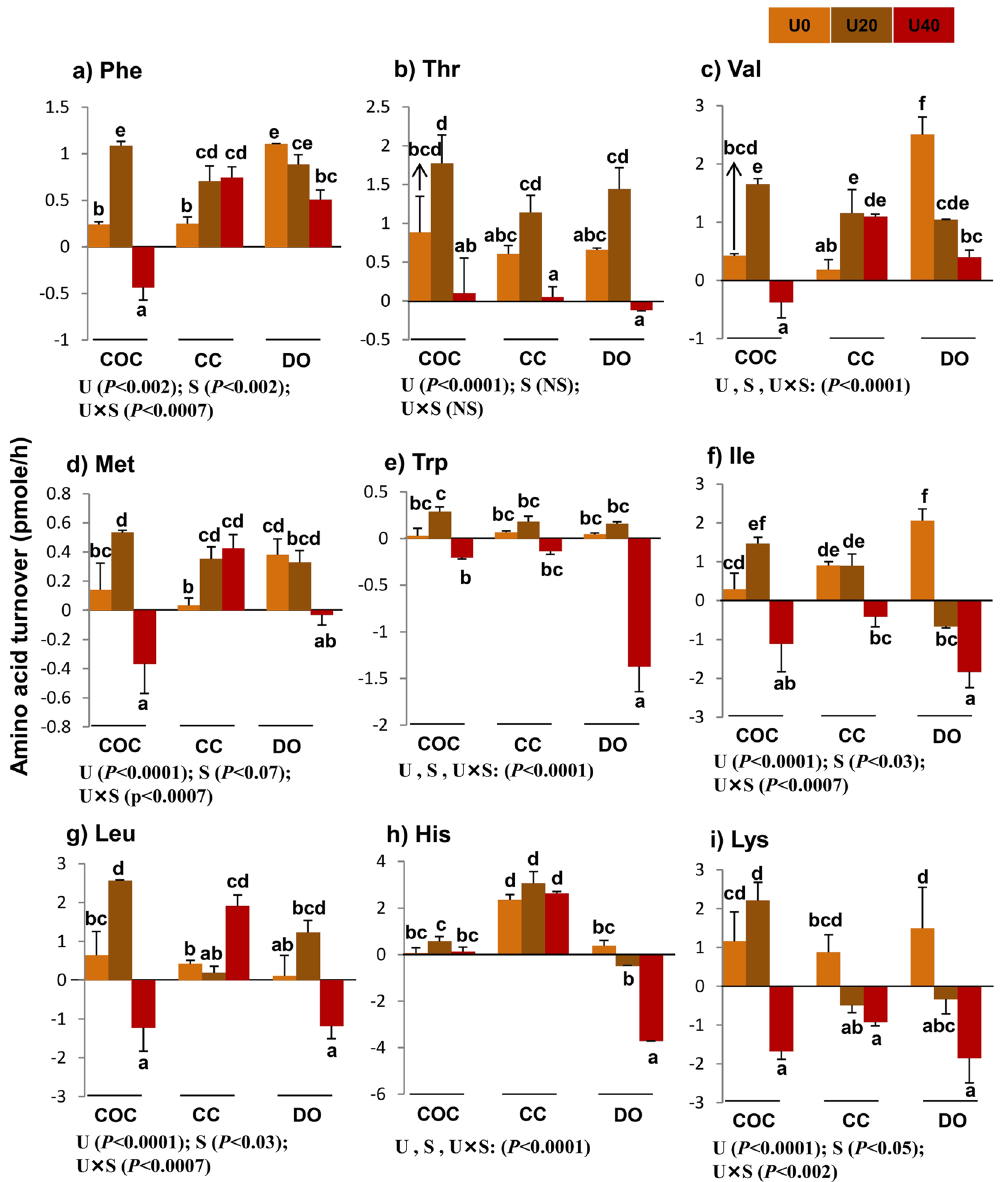
Figure 1. Effect of urea supplementation (0, 20, or 40 mg/dl) in maturation medium on the net depletion/ appearance of essential amino acids by bovine cumulus-oocyte complex, oocytectomized cumulus cells, or denuded oocytes after 24-h incubation. U0: control group (without urea); U20: 20 mg/dl urea; U40: 40 mg/dl urea. COC: cumulus oocyte complex; CC: cumulus cells; DO: denuded oocytes; U: the main effect of urea; S: the main effect of specimens (cell type: COCs, DOs, and CCs); U × S: interaction between urea and cell type. Data are presented as least squares means (LSM) ± standard error mean (SEM) indicated by two-way ANOVA over PROC GLM. Different letters (a, b, c, etc.) indicate significant differences between the treatments at P < 0.05. NS: